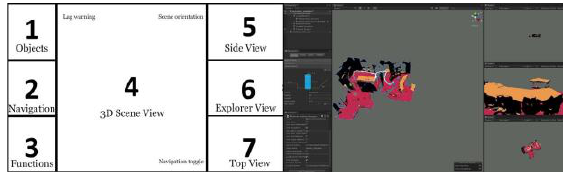
Figure 6: User interface. Left: conceptual overview. Right: the system as it is in use.